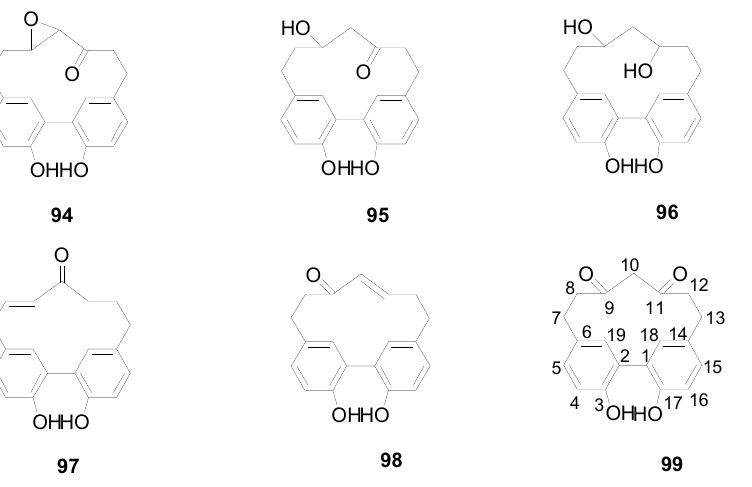
Figure 2. Structures of compounds 90 – 93 .